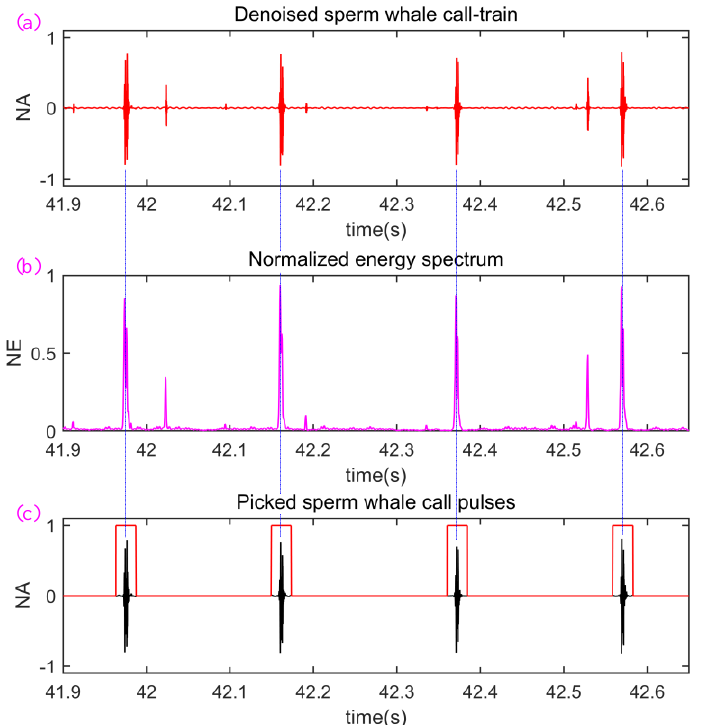
Figure 5. The removal process of low-energy signals. ( a ) Denoised sperm whale call-train; ( b ) NE spectrum; ( c ) picked sperm whale call pulses.